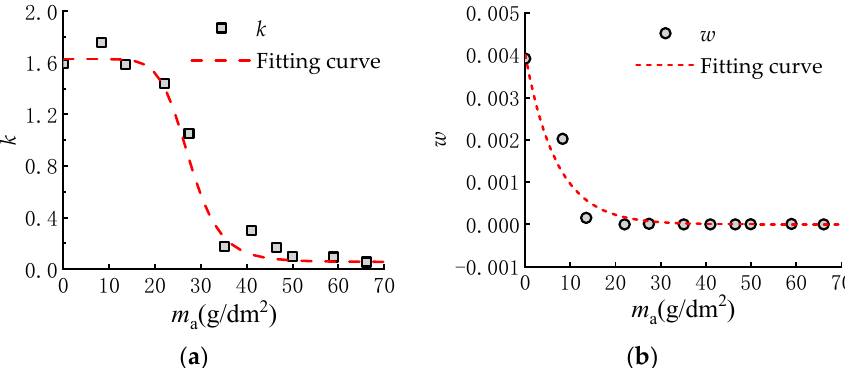
Figure 13. Variation curve of parameters k and w with corrosion degree: ( a ) parameter k ; ( b ) parameter w .